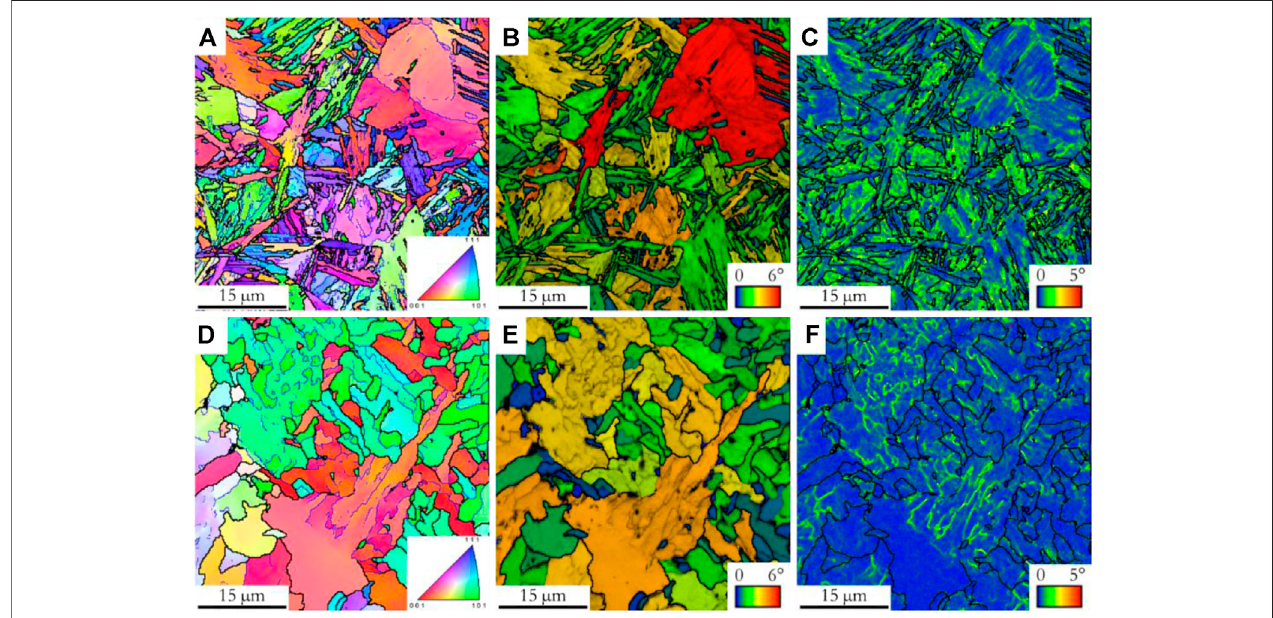
FIGURE2 | EBSD maps ofthe 10CrNi3MoV steel and its undermatched weldment: (A – C) as-receivedbase metal and (D – F) undermatched weldment. (A and D) IPF-Zmaps,and (BandE) GOSmaps,and (CandF) KAMmaps.Theblacklinesindicatehigh-anglegrainboundaries( > 15 ° ).Thebluelinesindicatethelow-anglegrain boundaries (2 – 15 ° ) (digital version in color).